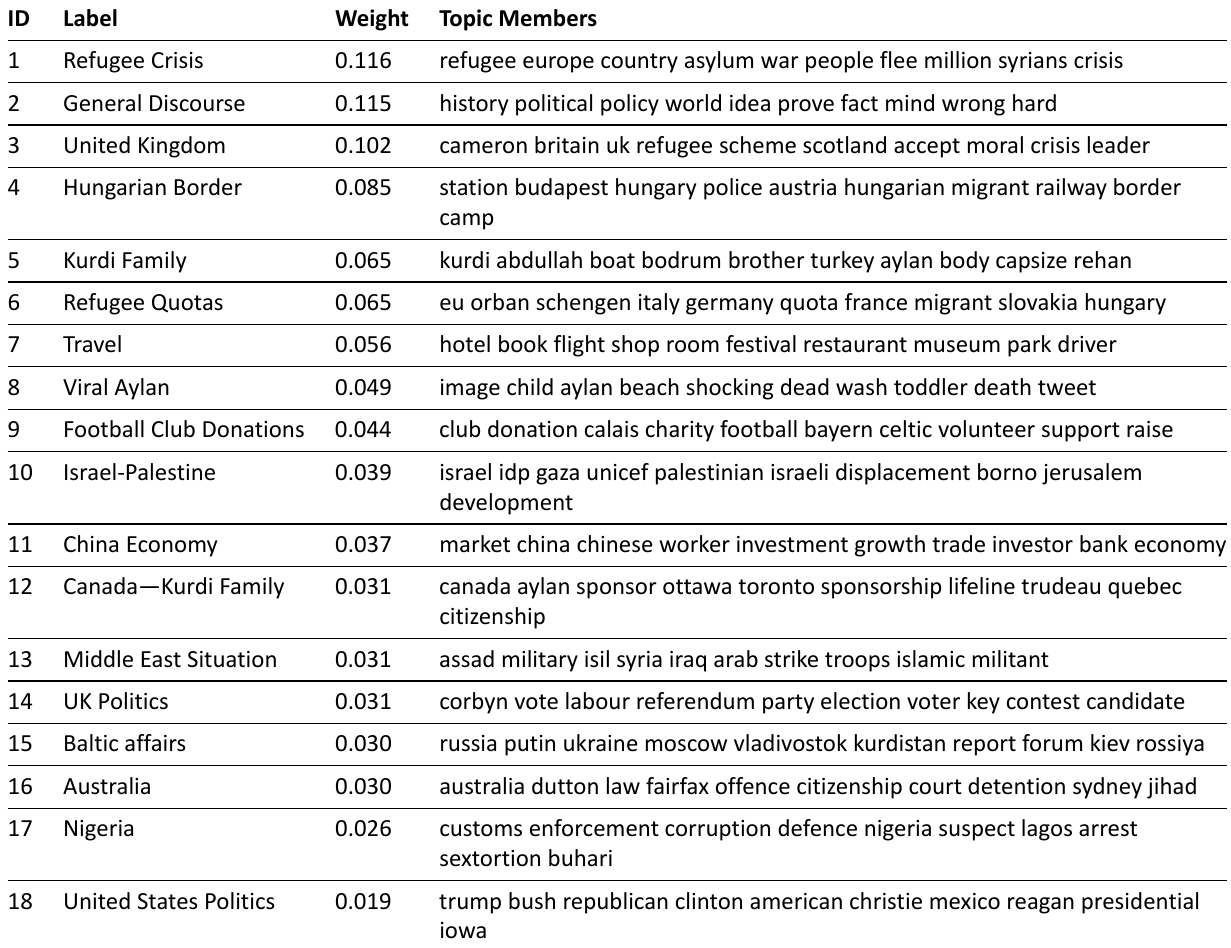
Table 1. Topic modeling for the newspaper